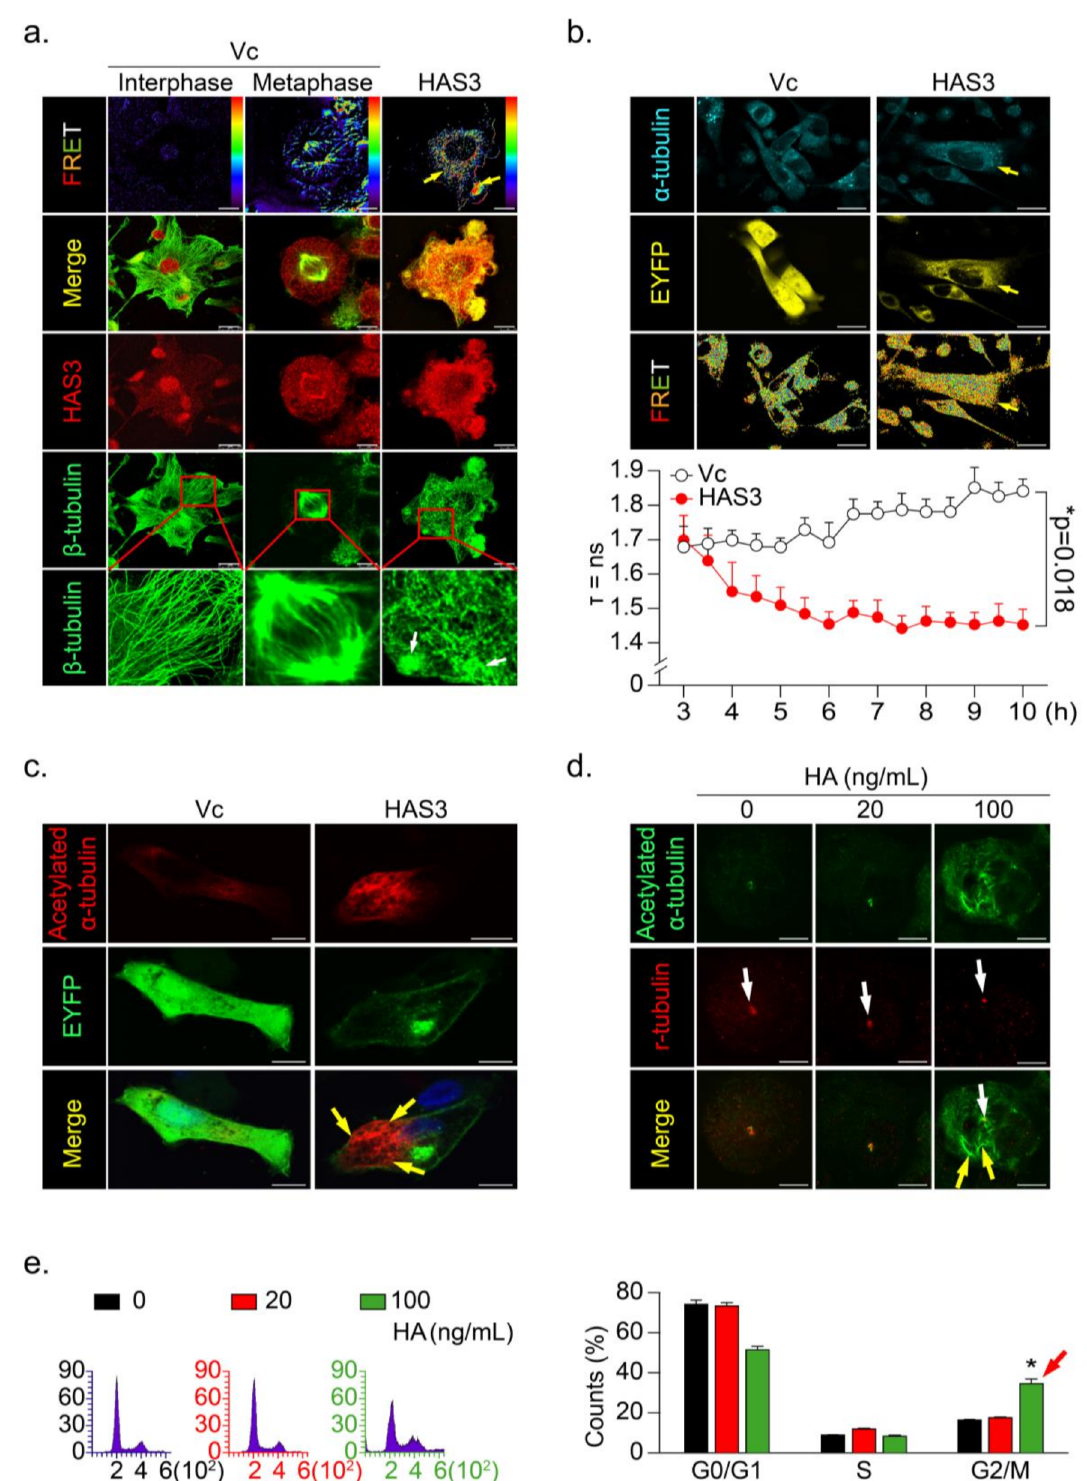
Figure 4. HAS3 overexpression promoted microtubule hyperacetylation through the direct binding of HAS3 to microtubules. ( a ) The interaction of β -tubulin with HAS3 in MDA-MB-231 cells was detected by FRET assay. HAS3/ β -tubulin protein complex formation in cells was examined under a confocal microscope imaging system via FRET analysis. Magnification, 630 × ; scale bar, 7.5 µ m; ( b ) Time-lapse measurement (FLIM assay) of the interaction of α -tubulin with HAS3 in MDA-MB- 231 cells. FLIM occurred between the donor fluorophore (AmCyan) and acceptor fluorophore (EYFP) upon excitation of the donor fluorophore, only when the distance between fluorophores was less than 10 Å. Magnification, 630 × ; scale bar, 25 µ